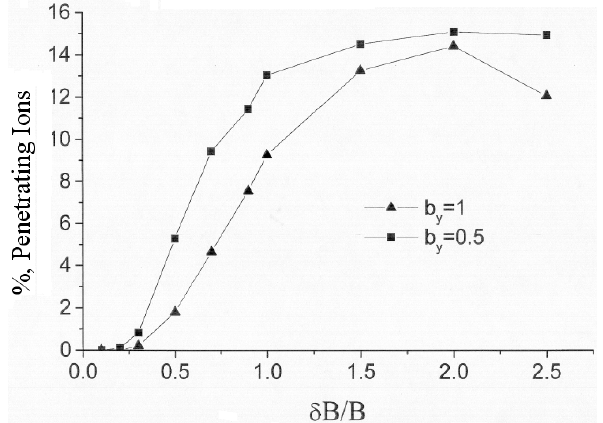
Fig. 6. The number of penetrating ions as a percentage of the total number of ions launched, as a function of the fluctuation level for two values of the shear parameter b y 0.5 (squares) and 1.0 (trian- gles).